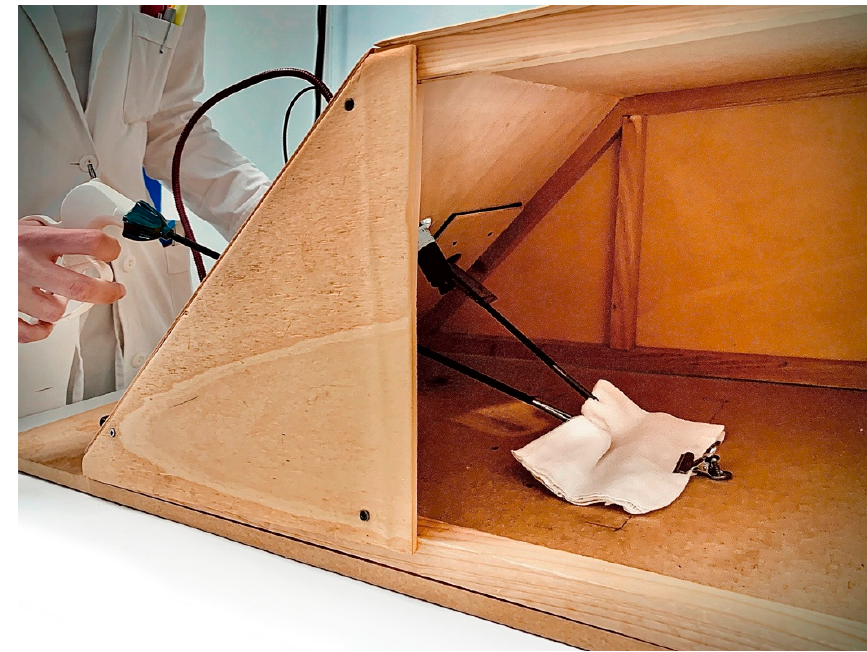
Figure 5. Internal operative space of LABOT during the performance of an easy training exercise.